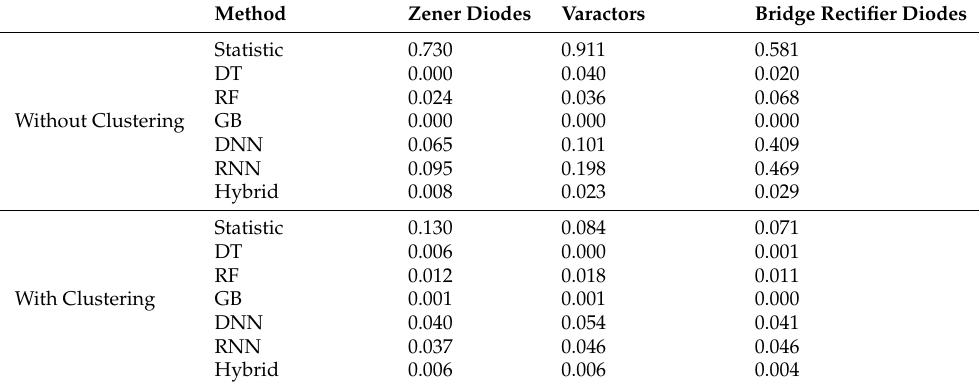
Table 9 lists the MRE error of the test data with and without clustering. The predictions